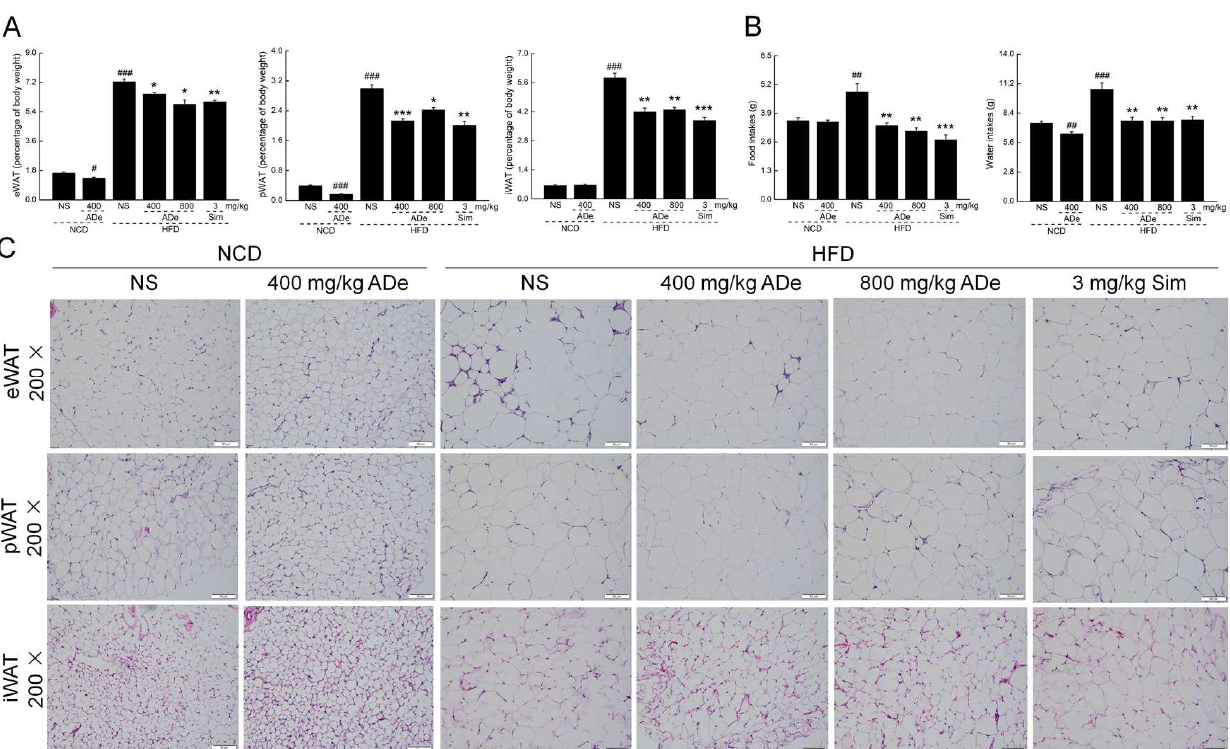
Figure 1. Effect of ADe on the WATs and food and water intake. ( A ) ADe suppressed the eWAT, pWAT, and iWAT indices in DIO mice (n = 6). ( B ) ADe decreased the food and water intakes in DIO mice (n = 6). ( C ) H&E staining of the eWAT, iWAT, and pWAT (200×; scale bar: 50 μm). # p < 0.05, ## p < 0.01, and ### p < 0.001 versus NCD-fed mice; * p < 0.05, ** p < 0.01, and *** p < 0.001 versus HFD-fed mice.